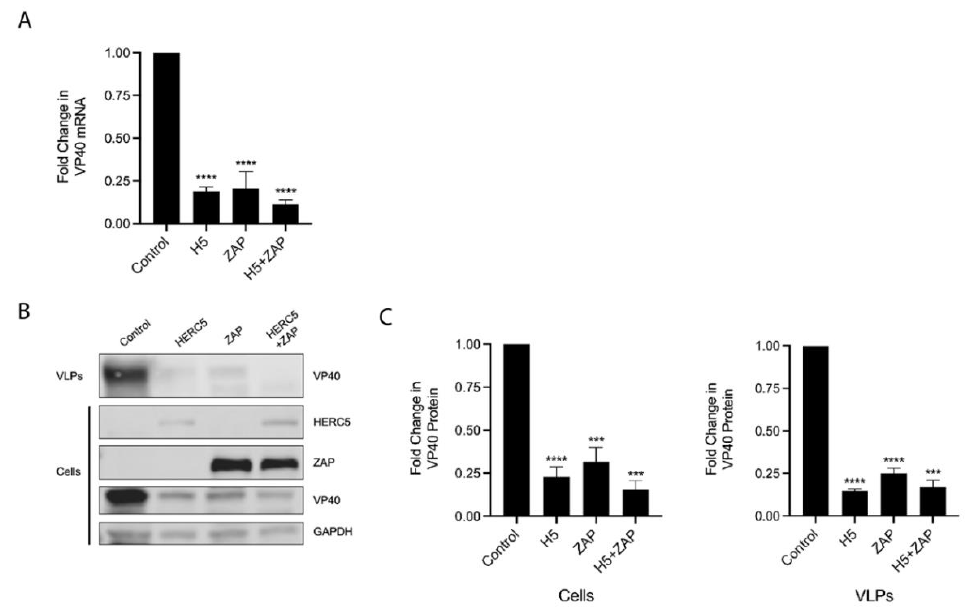
Figure 4. HERC5 restricts VP40 independently of ZAP. 293T ZAP knockout cells were co-transfected with plasmids carrying FLAG-tagged VP40 and either empty vector control, HERC5, ZAP (short